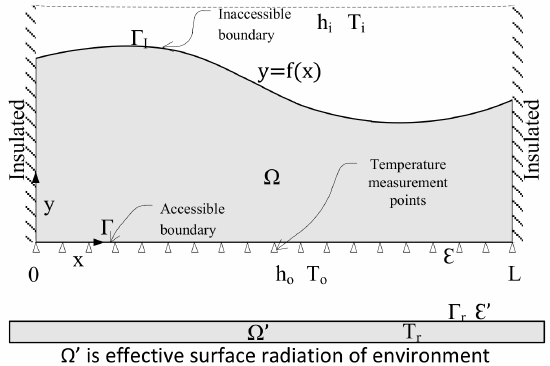
Figure 1. Physical model of inner wall boundary identification of thermal